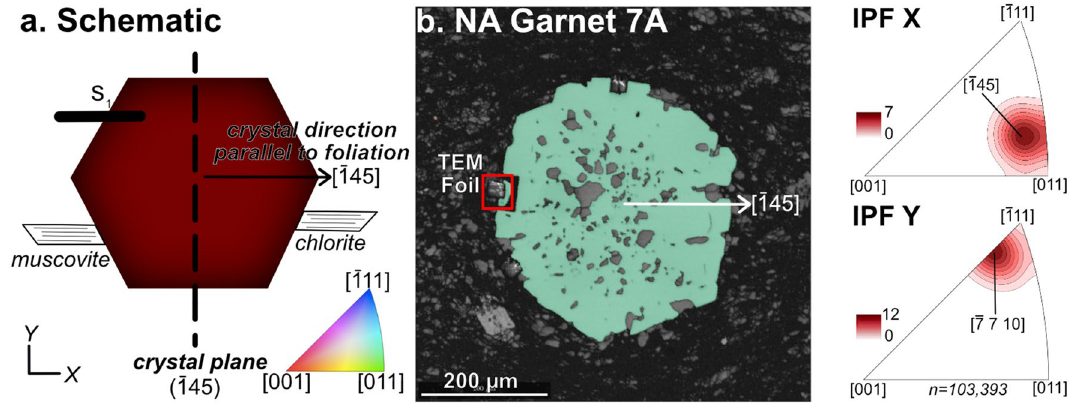
Figure 1. EBSD results. ( a ) Plotting schematic of garnet in B, showing garnet crystal direction and corresponding crystal plane. The trace of the S 1 foliation in the thin section is parallel to the horizontal (X) direction. XY coordinates are defined here as X: parallel to the horizontal direction of the thin section plane (parallel to foliation), Y: parallel to the vertical direction of the thin section plane (perpendicular to foliation). ( b ) Electron back scattered diffraction (EBSD) analyzed garnet crystal, color-coded for crystal direction parallel to the X direction and the S 1 foliation (color coding following inset in ( a )). Location of TEM foil (Fig. 2) is shown. TEM foil was cut perpendicular to (into) the thin section plane. Orientation data are plotted on the EBSD band contrast image. Inverse pole figures (IPF) X and Y show the crystal directions of garnet that are parallel (X) and perpendicular (Y) to the foliation. IPFs are contoured for multiples of uniform